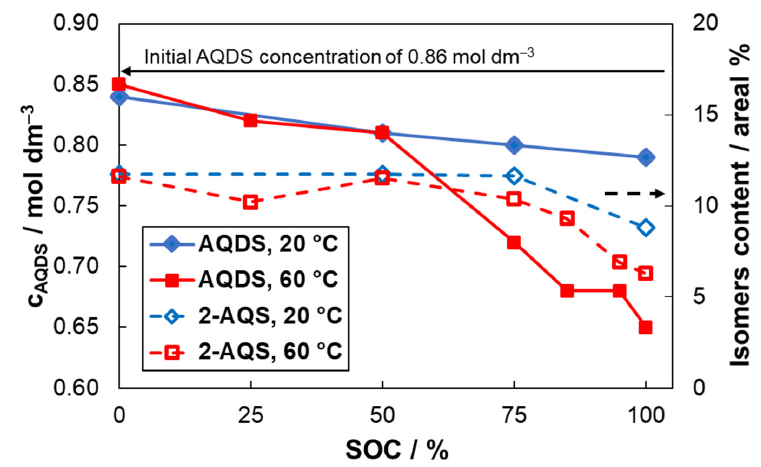
Figure 4. The effect of electrolyte SoC and storing temperature on the concentration of AQDS from UV–VIS spectrophotometry (primary y -axis) and areal % of 2-AQS (secondary y -axis) from HPLC after five days in a glass vial (initial SoC adjusted by charging in std. AQDS-HBr RFB